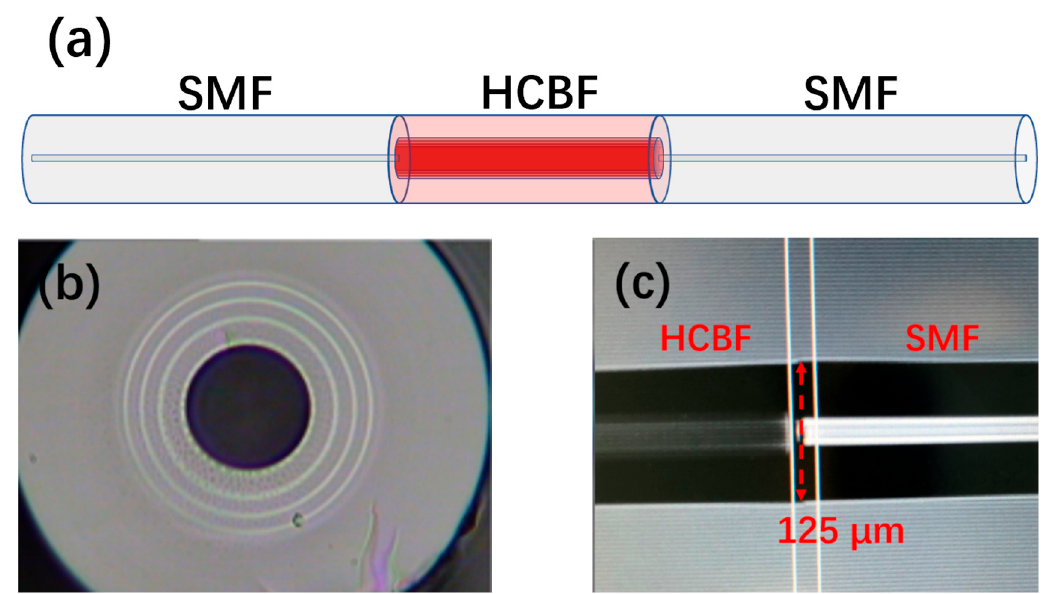
Figure 2. ( a ) Schematic diagram of the SMF–HCBF–SMF structure sensor; ( b ) microscopy image of the cross-section of the HCBF; ( c ) microscopy image of the splicing joint between the HCBF and SMF.